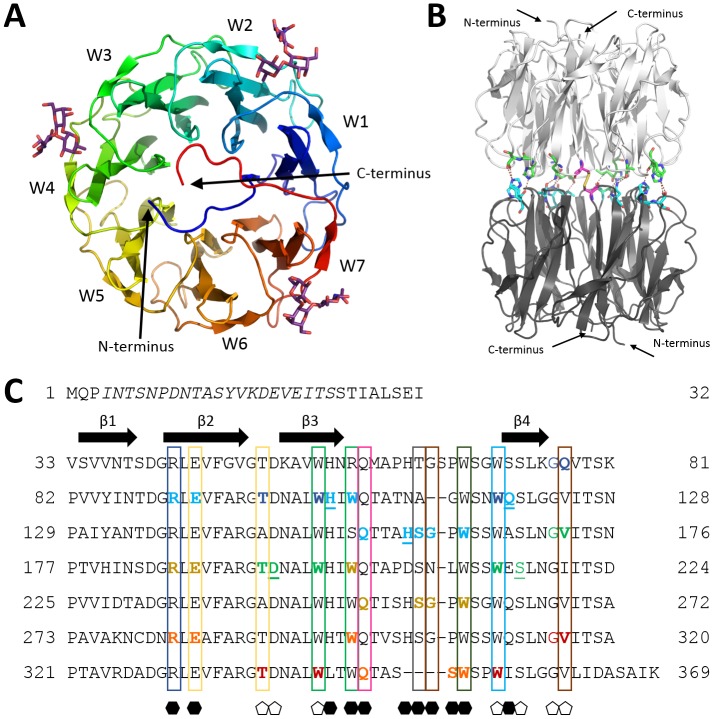
(A) PHL monomer (chain A) overall architecture with individual blades labelled. BGH trisaccharide molecules in sites 1F (between blades W1 and W2), 3F (between W3 and W4) and 6F (between W6 and W7) are shown as sticks. (B) Side view of PHL dimer with intermonomer contacts shown. Participating residues coloured in green for one monomer and cyan for the second monomer. Disulfide bridge formed by Cys279 is highlighted in magenta. (C) Alignment of PHL sequence repeats. Full arrows indicate individual β-sheets. Boxes highlight the conserved residues participating in ligand binding, the colours of the boxes correspond to the residue colouring in Fig 6A. Residues stabilizing Fuc ligands are indicated with an empty pentagon under the column, residues binding Gal ligands are indicated with a full hexagon under the column. Coloured residues in bold bind the corresponding monosaccharide, additional interactions with the oligosaccharide are shown in coloured regular font. The underlined residues only participate in binding through the water bridge. The colour of the residue stands for individual binding sites: site 1F (blue), site 2G (cyan), site 3F (green), site 4G (dark yellow), site 6G (orange), site 6F (red). Residues in italics were not resolved in any structure.